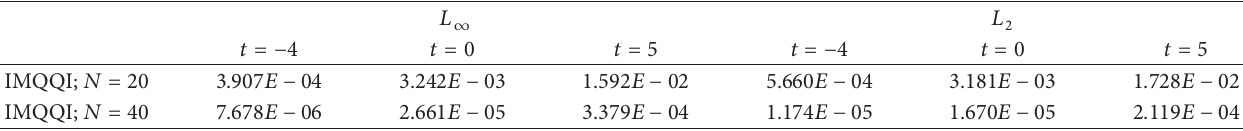
Table 6: The 𝐿 2 and 𝐿 ∞ errors of the IMQQI scheme with Δ𝑡 = 0.001 at different times of Experiment 3.